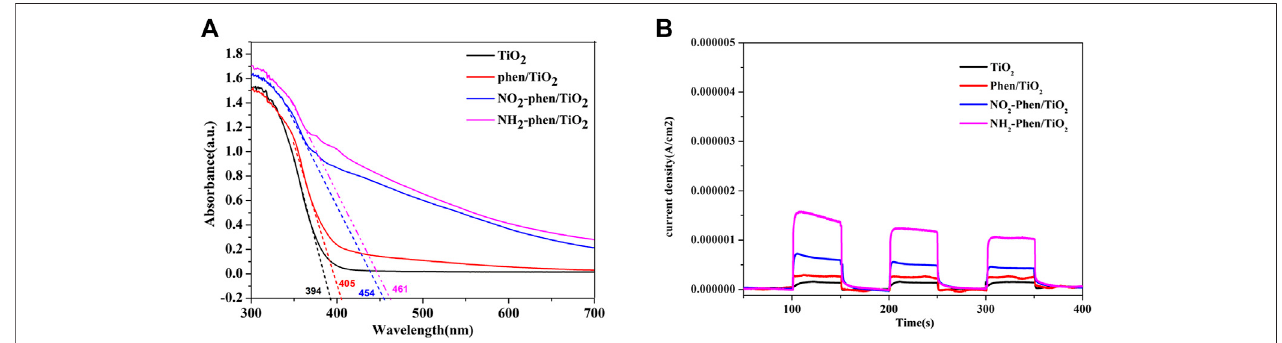
FIGURE 5 | UV – Vis spectra (A) and photocurrent response (B) of NH 2 -Phen/TiO 2 , NO 2 -Phen/TiO 2 , Phen/TiO 2 , and TiO 2